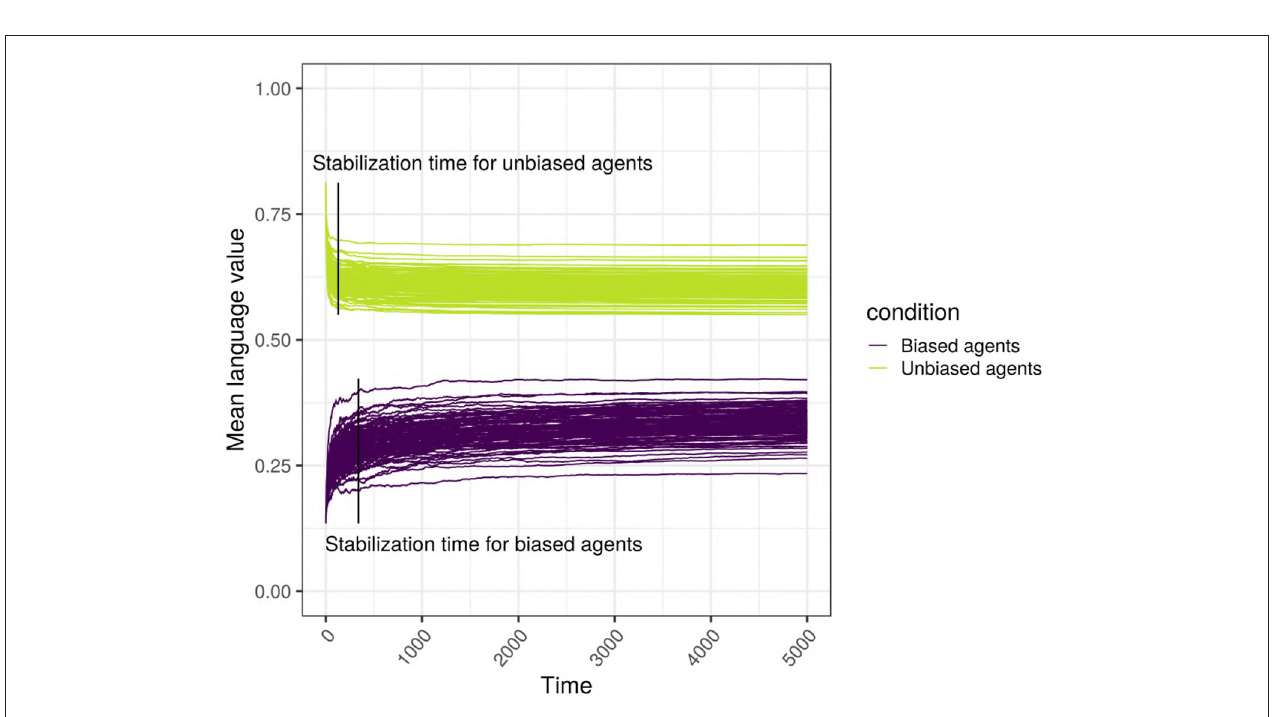
FIGURE 5 | Stabilization times for the biased and the unbiased agents. This example uses a scale-free network with 500 agents, with SAM agents, where 10% of the top influencers are strongly biased, in the presence of an initial